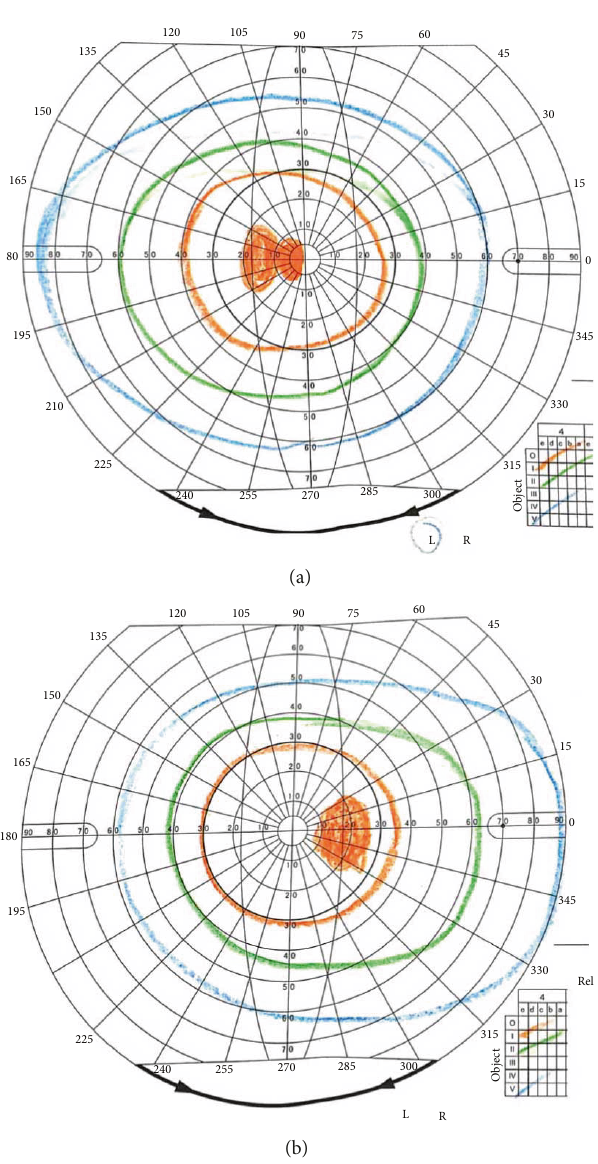
Figure 4: The Goldmann perimetry of the patient from Figure 3 showing bilateral cecocentral scotoma, which is di ffi cult to distinguish from the toxic metabolic optic neuropathy.